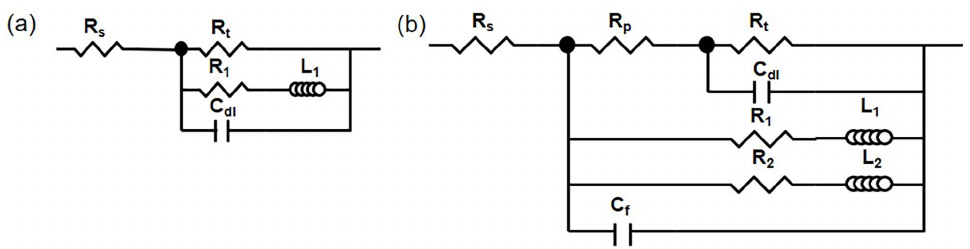
Figure 10. Equivalent circuit: ( a ) 1 h, ( b ) 12, and 24 h. Table 1. Fitting results of the EIS.